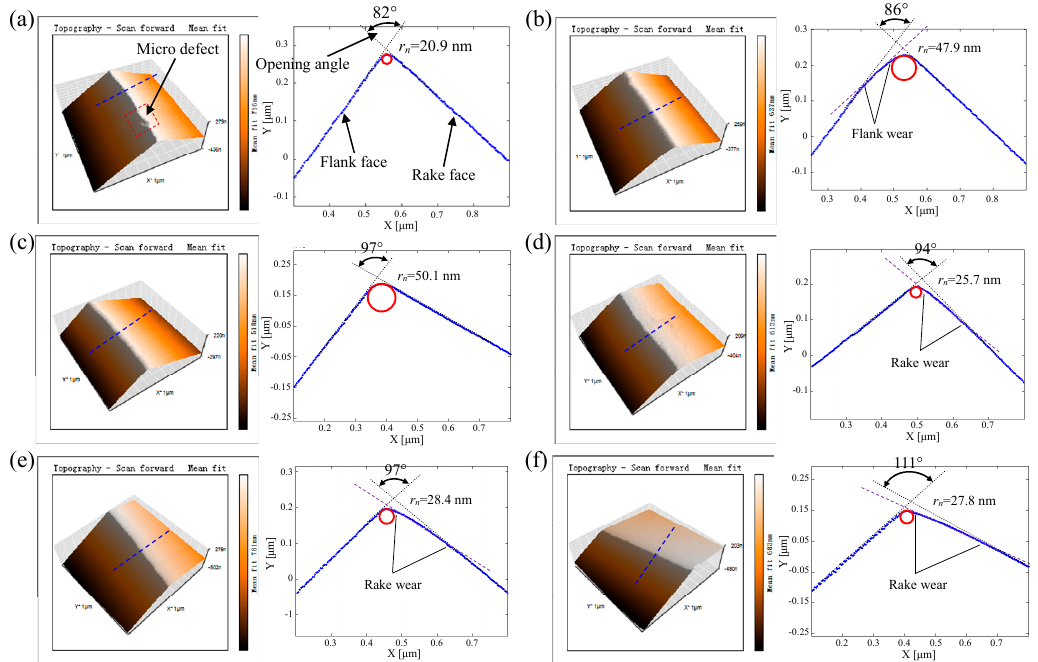
Figure 11. Comparison of the cutting edge quality before and after the tool-edge passivation: ( a ) before passivation; ( b ) after the 2-min traditional passivation method; ( c ) after the 2-min passivation at the depression angle of 45°; ( d ) after the 2-min passivation at the depression angle of 60°; ( e ) after the 4-min passivation at the depression angle of 60°; ( f ) after the 6-min passivation at the depression angle of 60°.